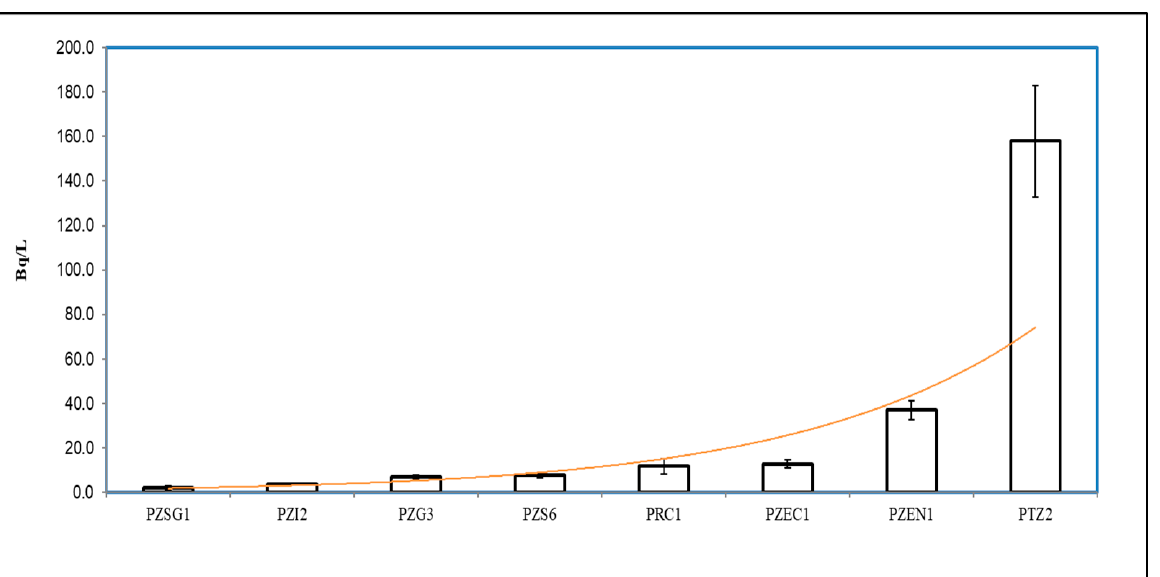
Table 5. Uranium Isotope Ratios Detected in the Monitored Piezometers (Median Values) [6].